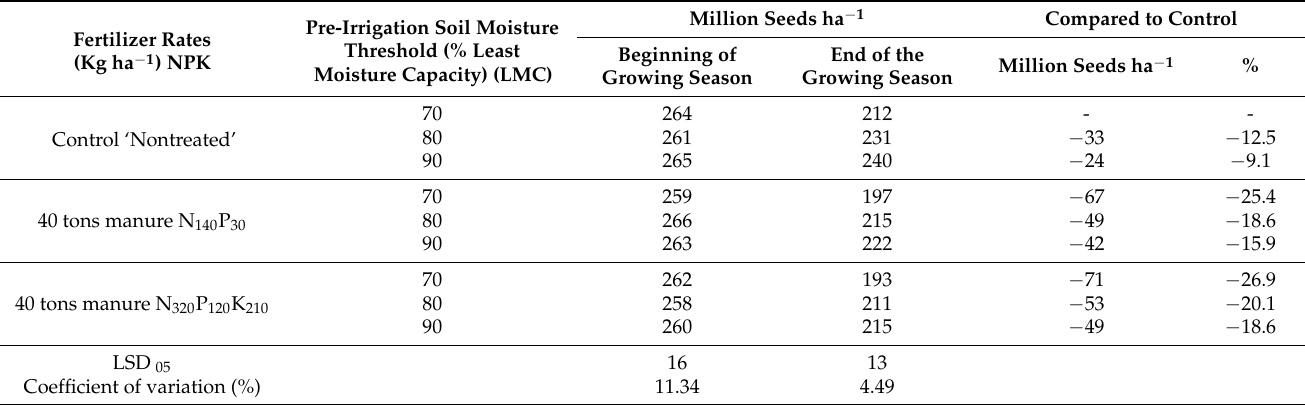
Table 3. Investigation of soil weed seedbank depending on the combination of fertilizers and pre- irrigation soil moisture levels.